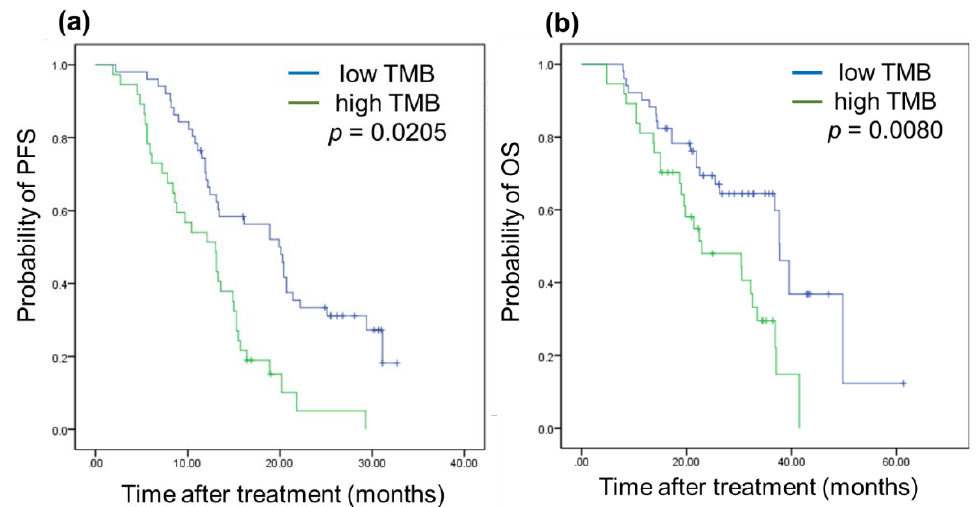
Figure 2. Kaplan-Meier curves of progression-free survival (PFS, ( a )) and overall survival (OS, ( b )) according to the different expression levels of TMB. p -values were determined using the log-rank test.